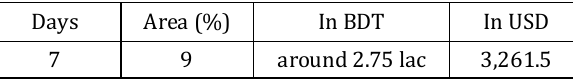
Fig. 5. Study area and